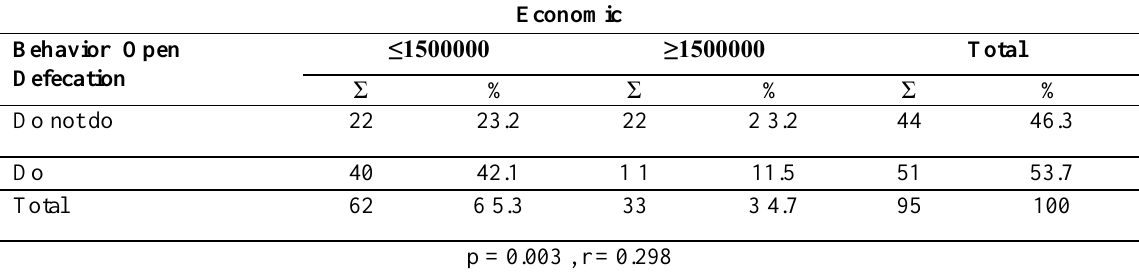
Table 2. The relationship between economic background and open defecation behavior in school age